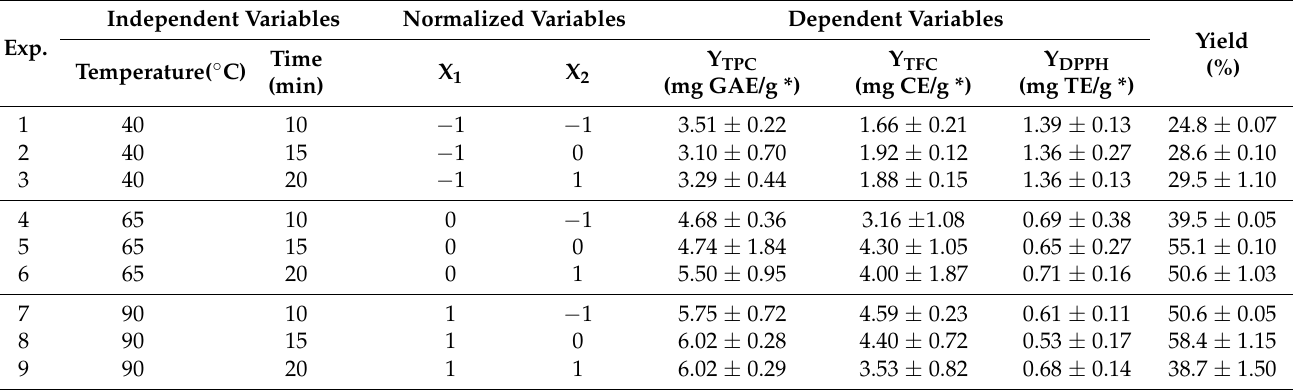
Table 4. Set of experiments and experimental results.